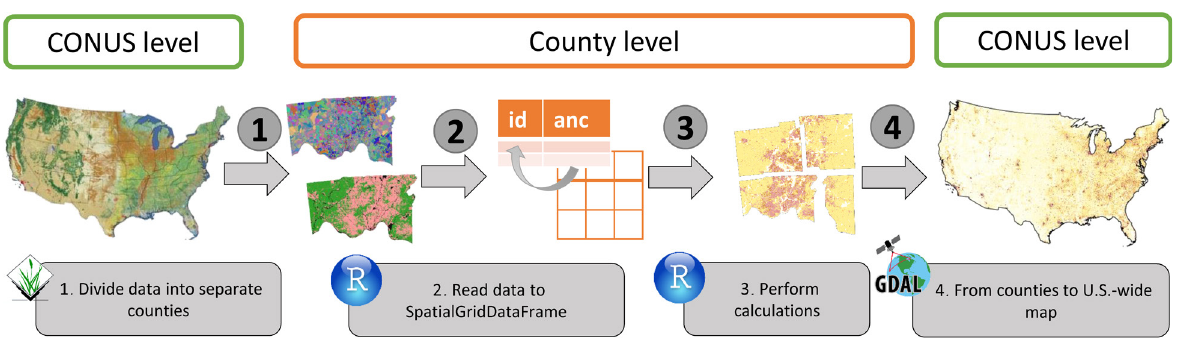
Fig. 1. Process of handling large datasets in